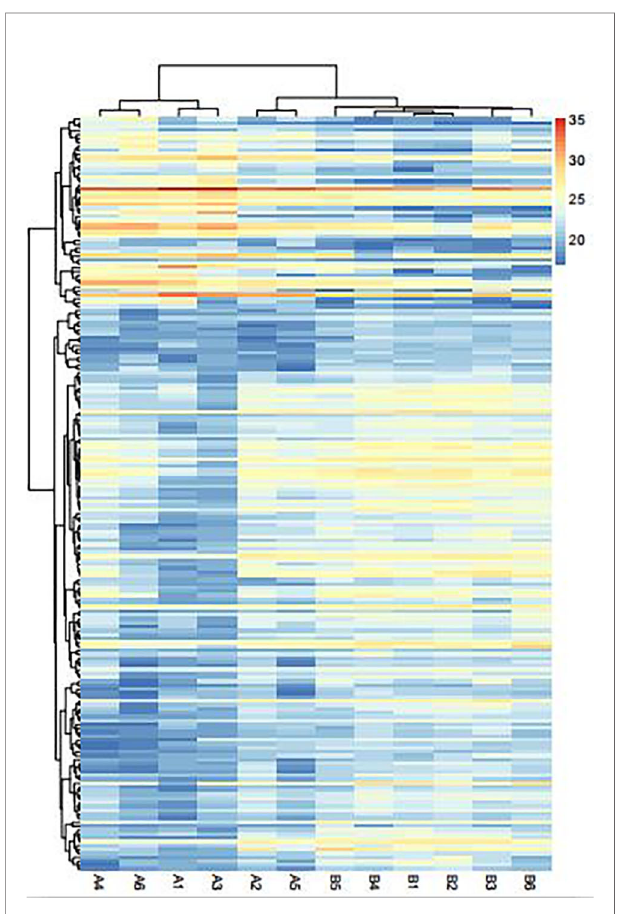
FIGURE 3 | Heat map of the DEPs between AS (A1 – A6) and No-AS (B1 – B6) groups. Red areas are the upregulated proteins, and the blue areas are the downregulated proteins.